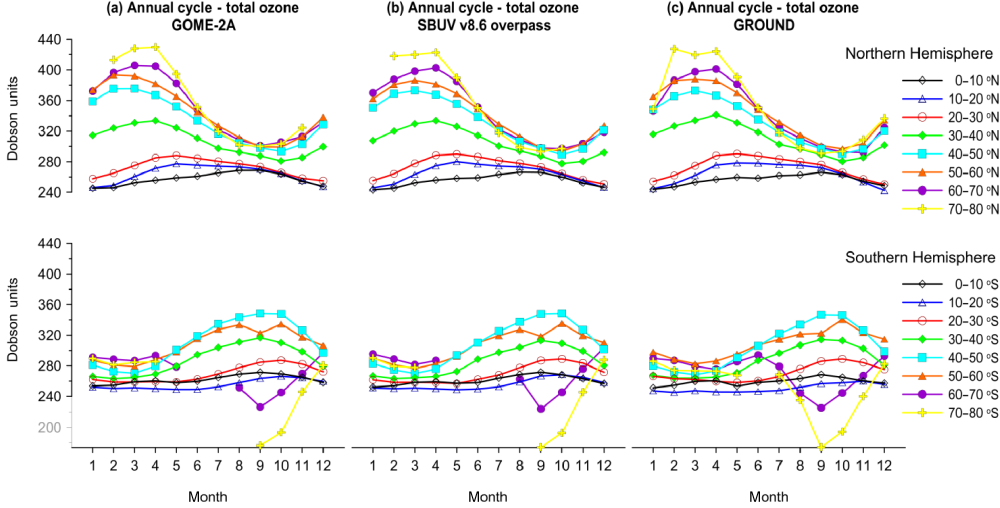
Figure 3. Comparison of the annual cycle of total ozone from GOME-2A with that from SBUV (v8.6) satellite overpass data and GB observations in the period 2007–2016 based on station data averaged per 10 ◦ latitude zones. The annual cycle is distorted above 60 ◦ S due to the Antarctic ozone